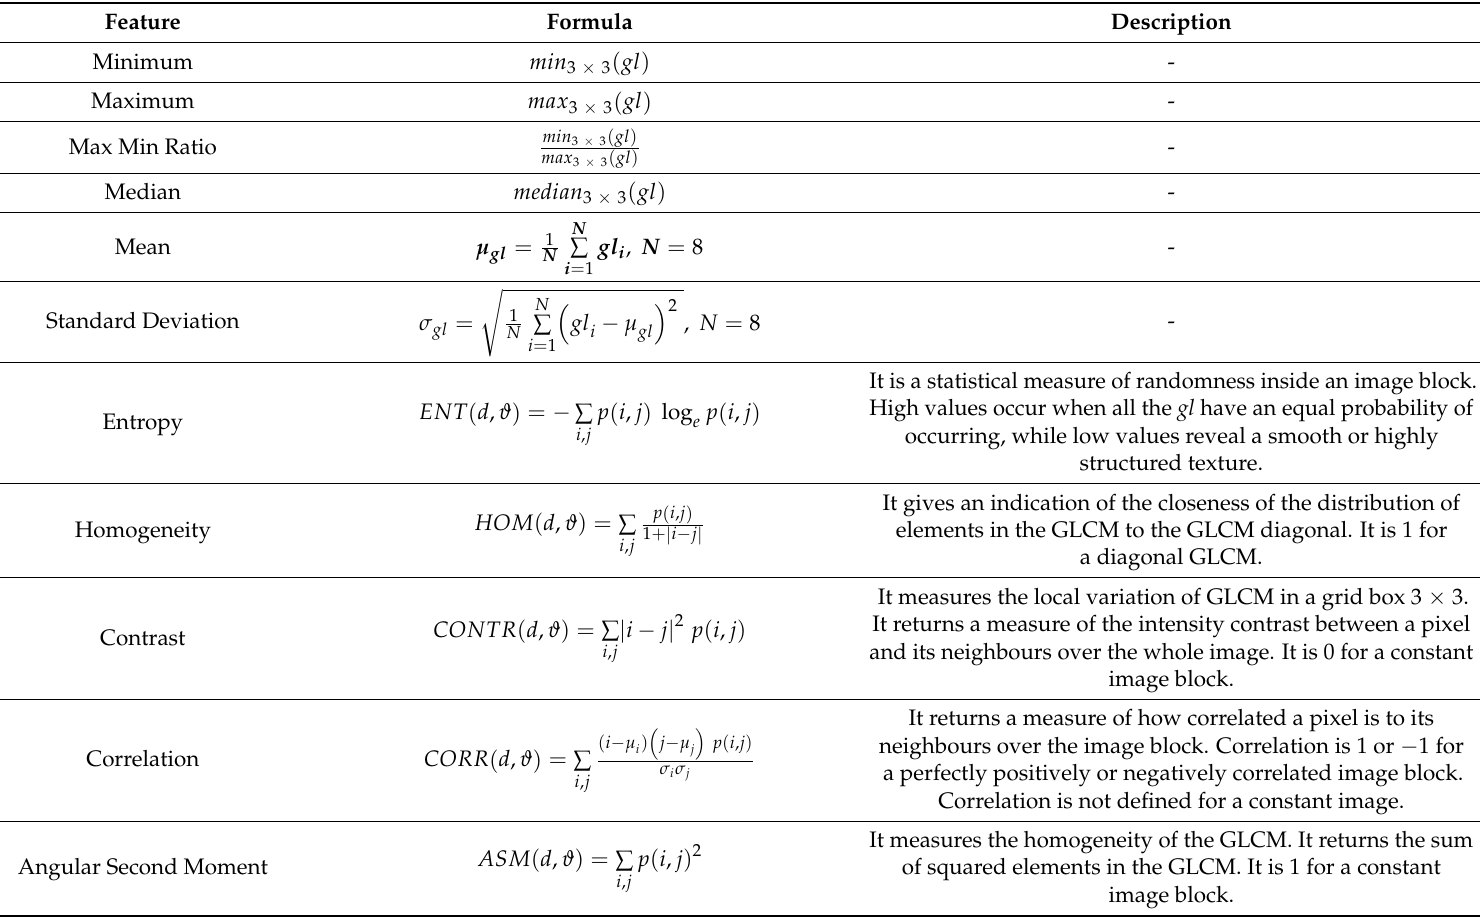
Table 1. Tonal and textural features. GLCM stands for Grey Level Co-occurrence Matrix (see main text for